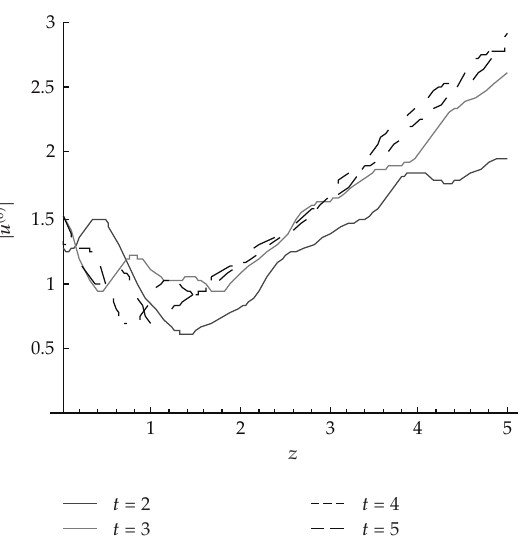
Figure 18: The zero-order approximation | u (cid:3) 0 (cid:4) | at α (cid:8) 1, T (cid:8) 10, γ (cid:8) 02 for di ff erent values of t , considering only one term in the series (cid:3) M (cid:8) 1 (cid:4) .